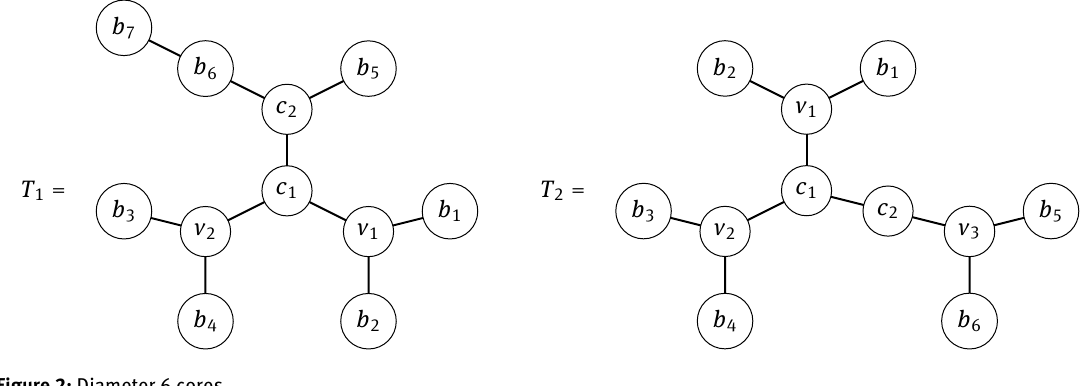
Figure 2: Diameter 6